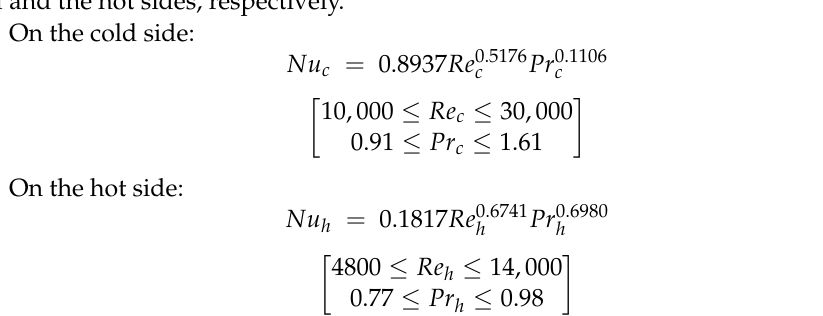
Figure 6. The difference between the correlations and the experimental results on ( a ) the cold side and ( b ) the hot side.